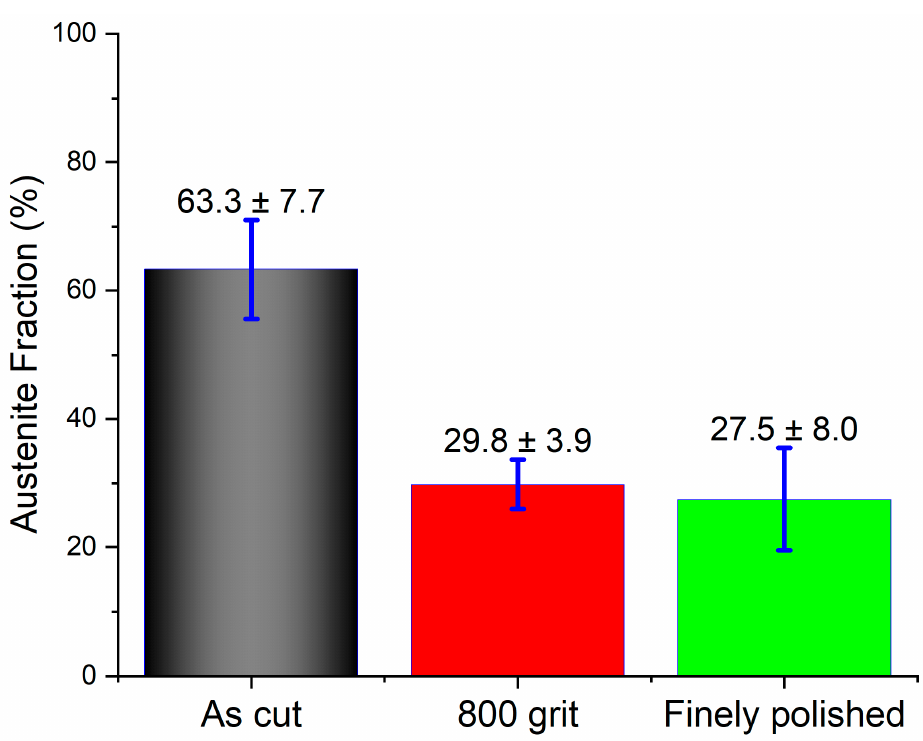
Figure 5. Retained austenite fractions analyzed using 25 sets of XRD data acquired from the same AM 17-4 part with three different surface finishes. “As cut” refers to the unpolished surface after cut using a low-speed saw. “800 grit” refers to a surface polished with an 800-grit sandpaper disc. “Fine polished” refers to a mirror-finish surface prepared following the steps described in the paper. The uncertainties are reported in one standard deviation.